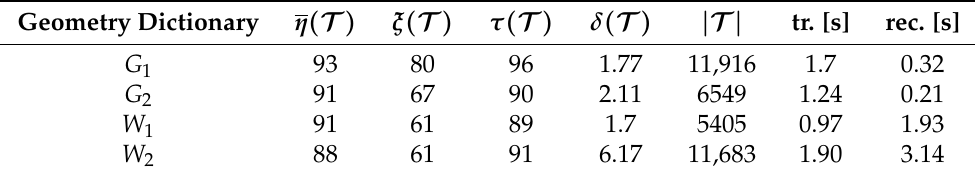
Table 1. Quality measures for the studied geometries. Algorithm: Preconditioned algorithm Packing for Parallelograms.